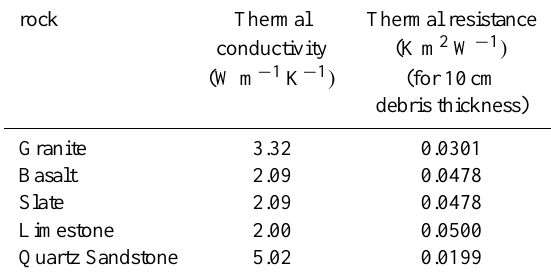
Table 2. Thermal conductivity for different rock types (Gupta, 2003) and the derived thermal resistance for a 10cm thick layer of the respective material.